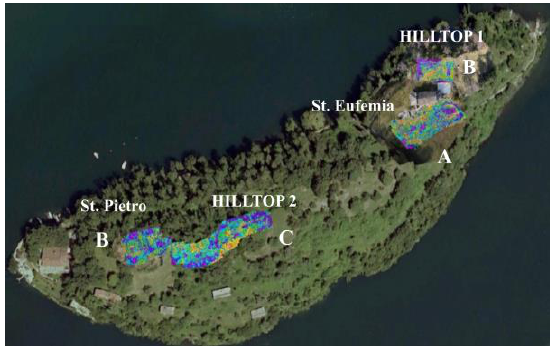
Fig. 9. Thermal orthophotos for the investigated sites.